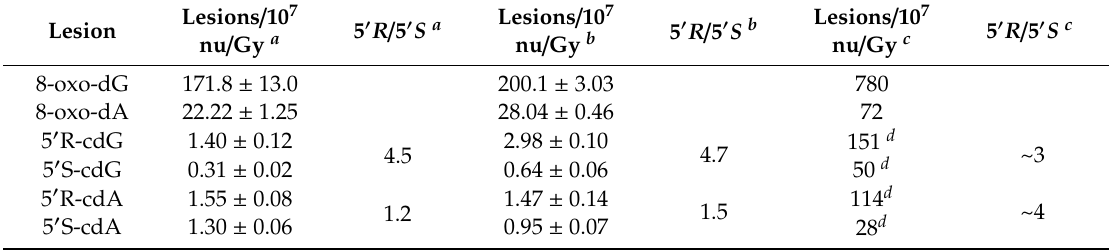
Table 2. The levels (lesions / 10 7 nu / Gy) of 8-oxo-dG, 8-oxo-dA, 5 (cid:48) R -cdG, 5 (cid:48) S -cdG, 5 (cid:48) R -cdA and 5 (cid:48) S -cdA